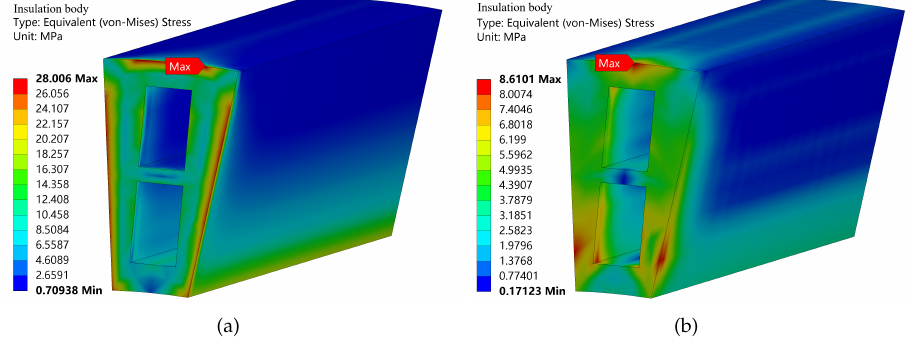
Figure 11. TMS in the DSOF motor stator insulation under seawater pressure. ( a ) Normal pressure. ( b ) Deep-sea pressure 20 MPa.